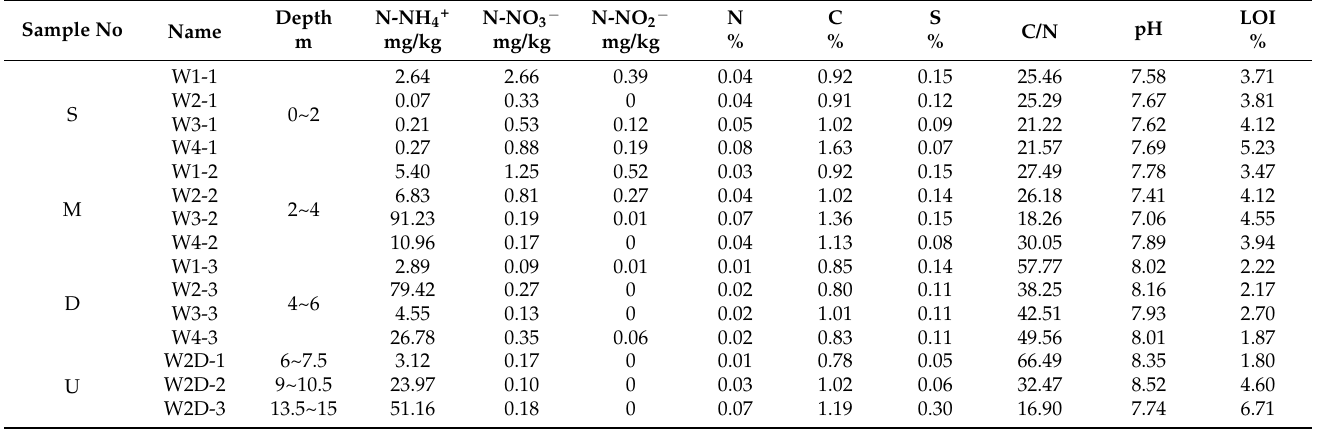
Table 1. Chemical and physical characteristics of soil